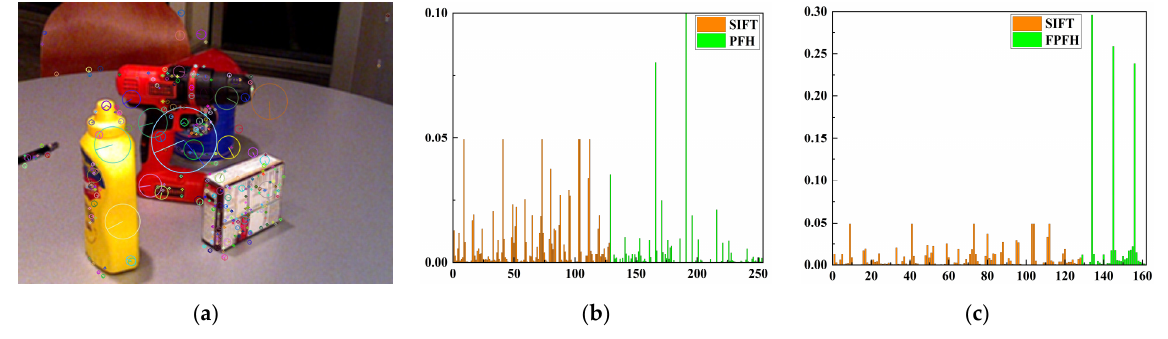
Figure 9. Extracted SIFT feature points and feature histograms of SIFTPFH and SIFTFPFH at pixel ( 374, 373 ) . ( a ) Extracted SIFT feature points; ( b ) SIFTPFH feature histogram; ( c ) SIFTFPFH feature histogram. Figure 8. An example of an RGB-D image in the YCB dataset. ( a ) RGB image; ( b ) depth image.